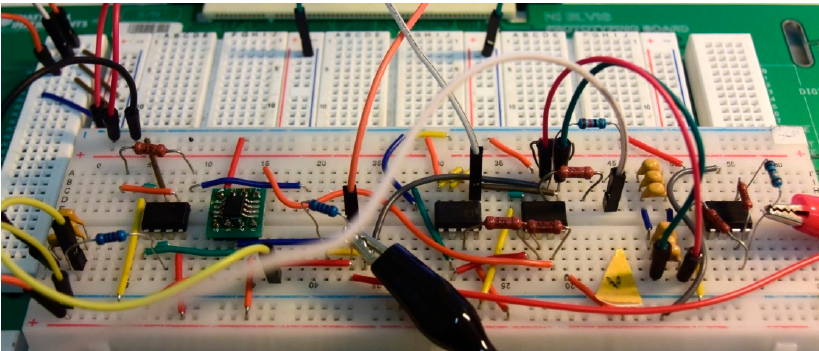
Figure 20. The circuit used in the experiments. Crocodile clips attach the coil.